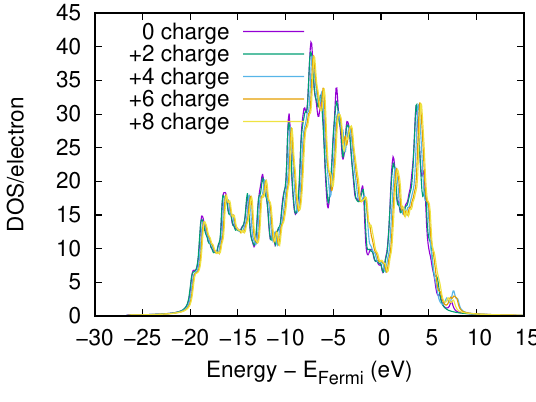
Figure 3. DOS for a SWCNT when electrons are removed from